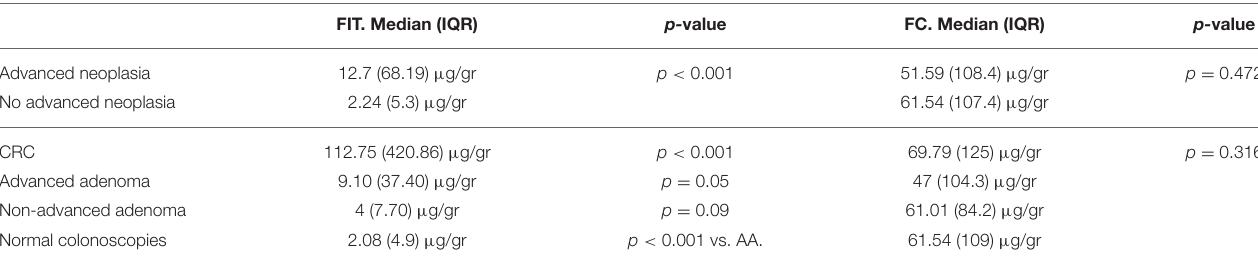
TABLE 2 | Median values of FIT and FC results in advanced neoplasia, CRC, advanced adenomas, non-advanced adenomas and normal